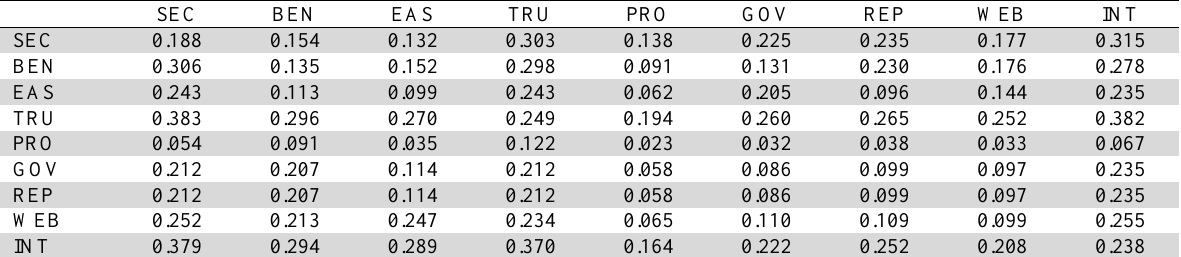
The results of direct and indirect effects